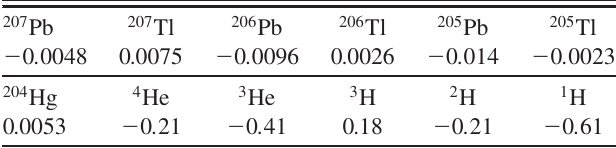
TABLE IV. The (cid:8) from fragmentation of the most common ions created in the collimator as calculated with Eq. (3) for ¼ 0 (cid:1) p=p 0